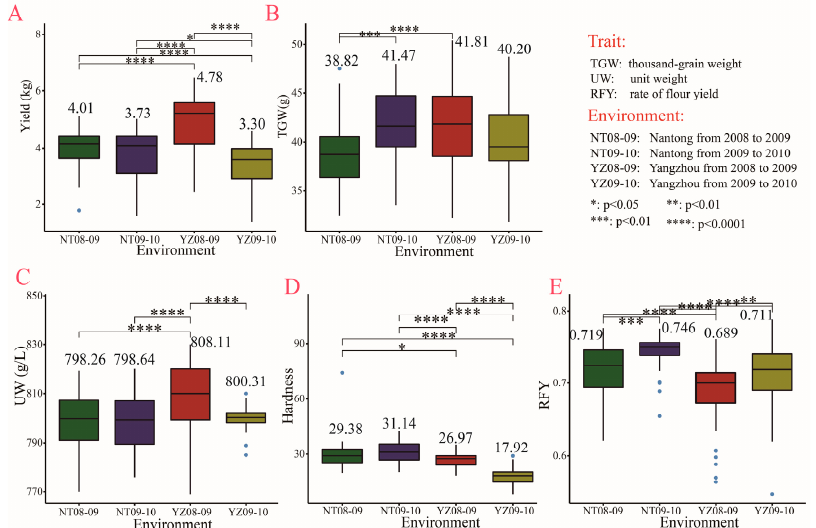
Figure 3. Yield and grain related traits in four growth environments. ( A – E ) Comparison among four growth environments in yield ( A ); thousand-grain weight ( B ); unit weight ( C ); hardness ( D ) and rate of flour yield ( E ). Box diagrams present the data in the interquartile ranges. The lines across boxes, whiskers, and blue circles denote the median values, the 10th and 90th percentiles, and outliers, respectively. The number above the box represents the average level of trait in each treatment. *, **, ***, and **** denote significant differences at the 0.05, 0.01, 0.001, and 0.0001 levels, respectively. NT08-09 and NT09-10 showed higher values of PC, WGC, SSV, FN, a*, b*, ST, PV, and LAS, but lower values of L* than YZ08-09 and YZ09-10 (Table 1). No significant differences in FT and DW were observed in any pairwise comparison of the four growth environments (Table 1). For other dough rheological properties (BV and P/L) and solvent retention properties (SS and SCS), there were great differences between different years in the same station (Table 1), indicating that these properties are easily affected by climatic conditions.